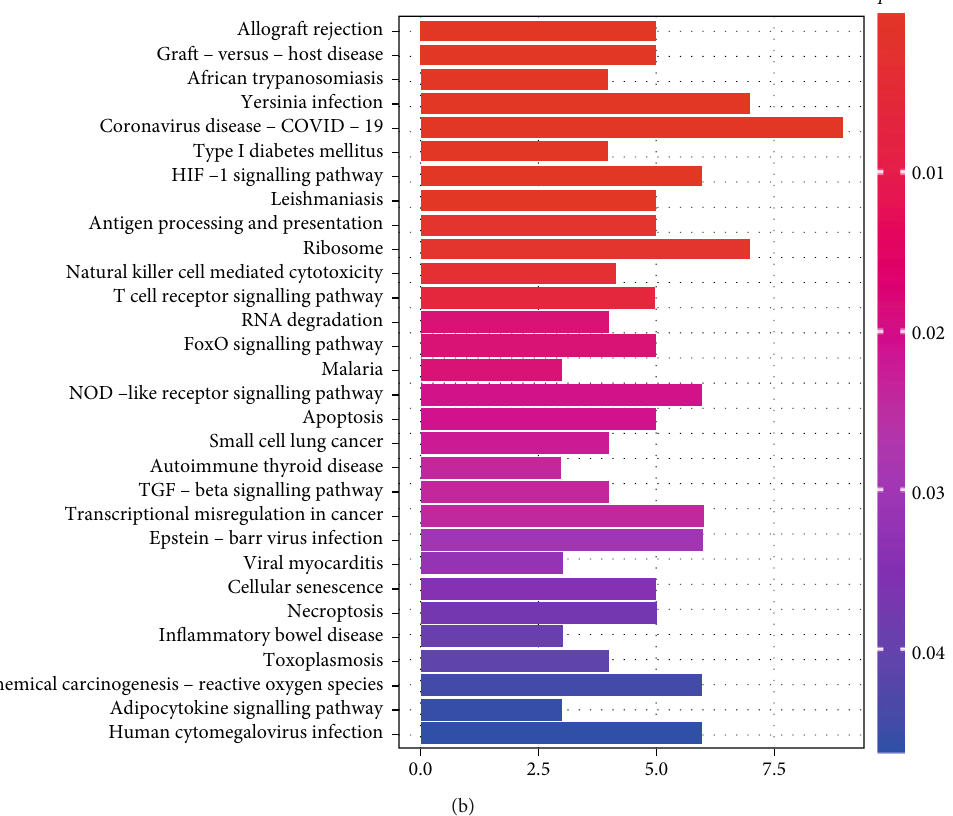
Figure 4: GO and KEGG pathway analysis. (a) GO analysis of genes involved in turquoise module. (b) Enriched pathways of genes in turquoise module by the